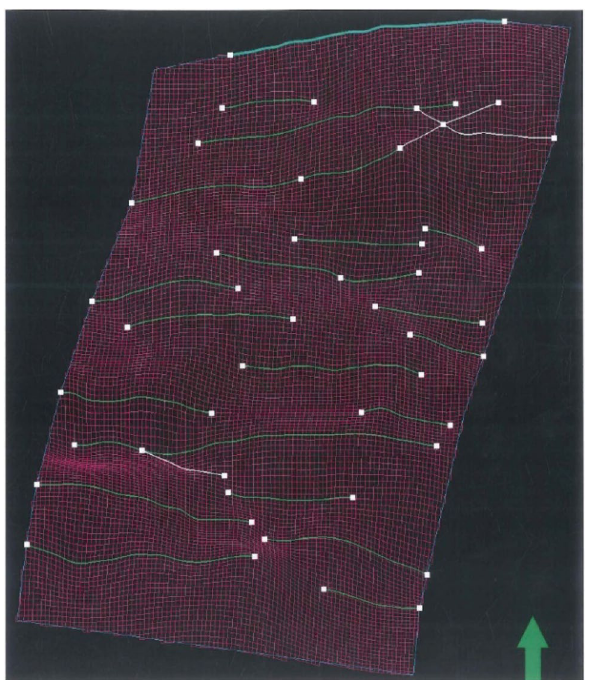
Fig. 10 100 m × 100 m grid used in structural model of C-reservoir ST field